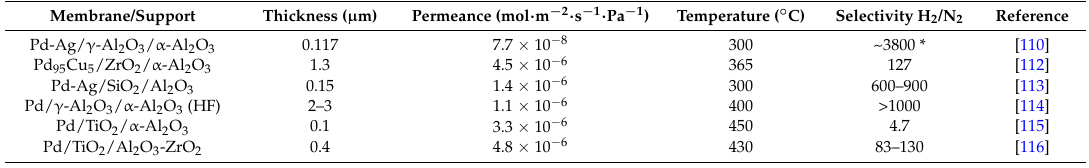
Table 6. Comparison of the hydrogen permeation for various composite